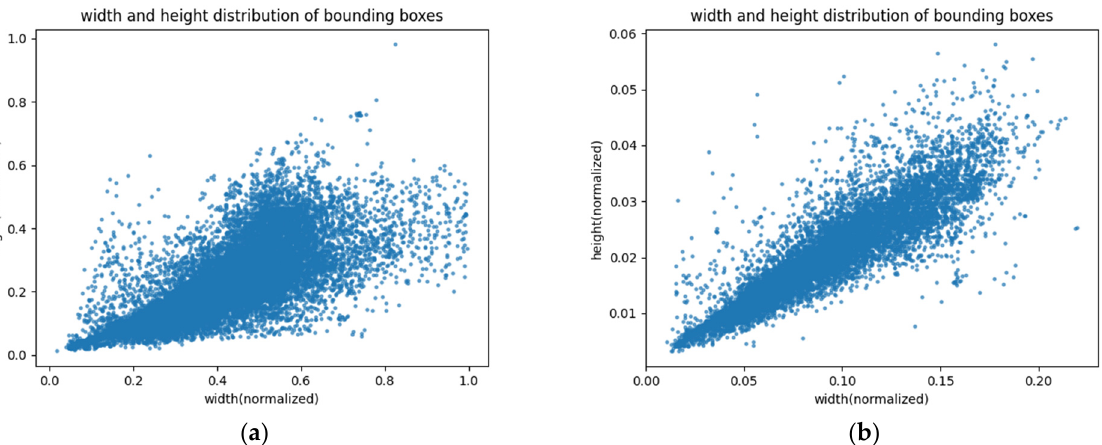
Figure 6. The size distribution of the normalized ground truth bounding boxes. ( a ) The size distribution for vehicles; ( b ) the size distribution for license plates.